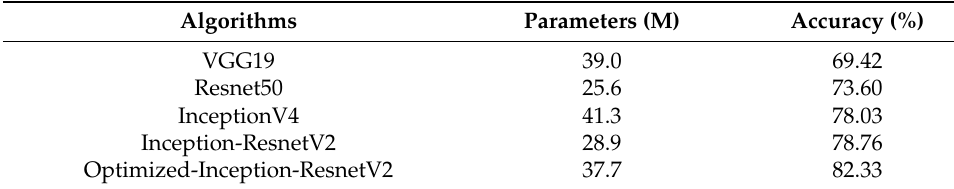
Table 8. The comparison results of four algorithms.